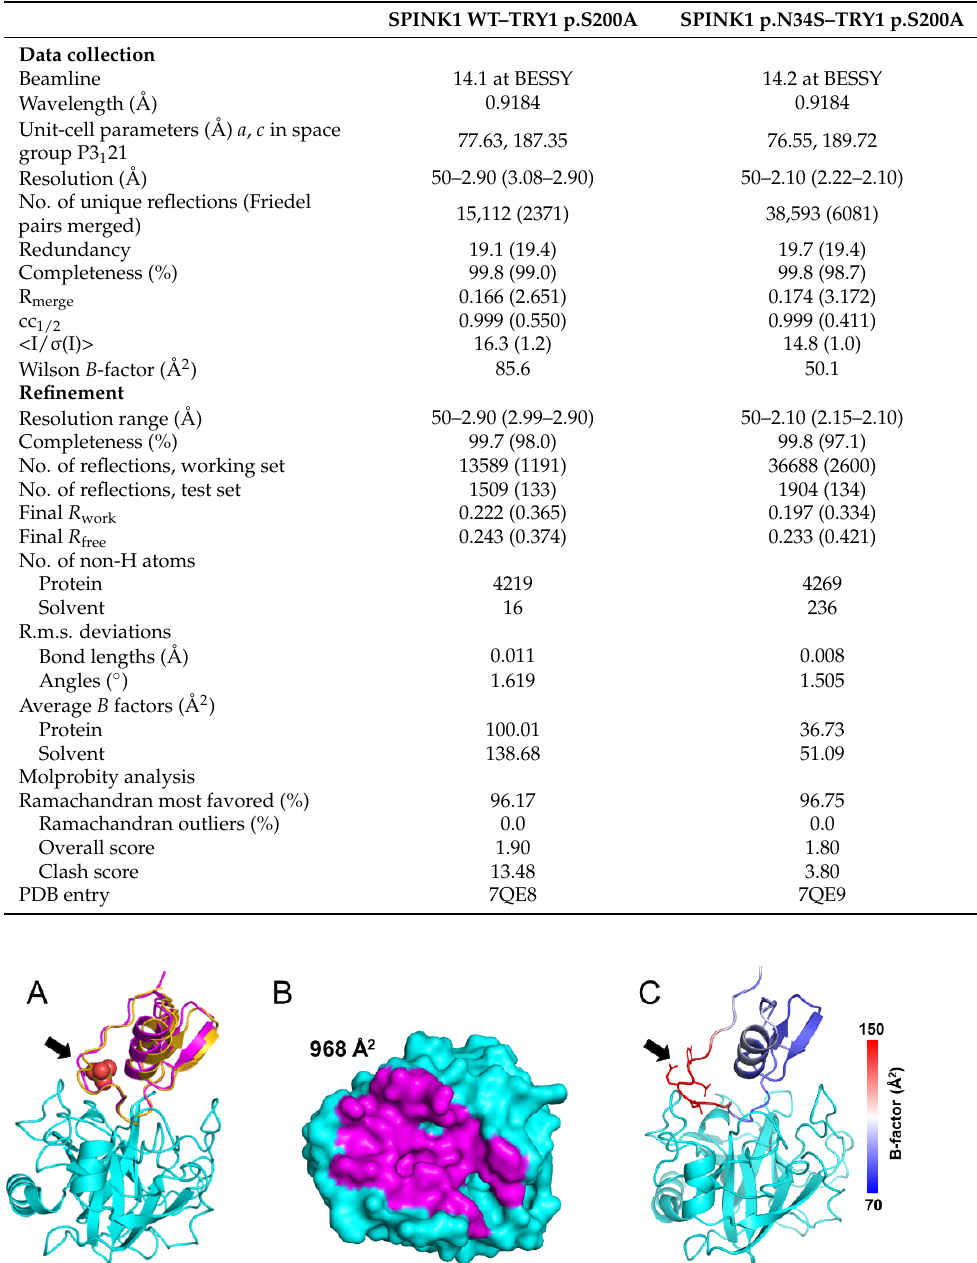
Table 1. Data collection and refinement of SPINK1–TRY1 p.S200A complexes.